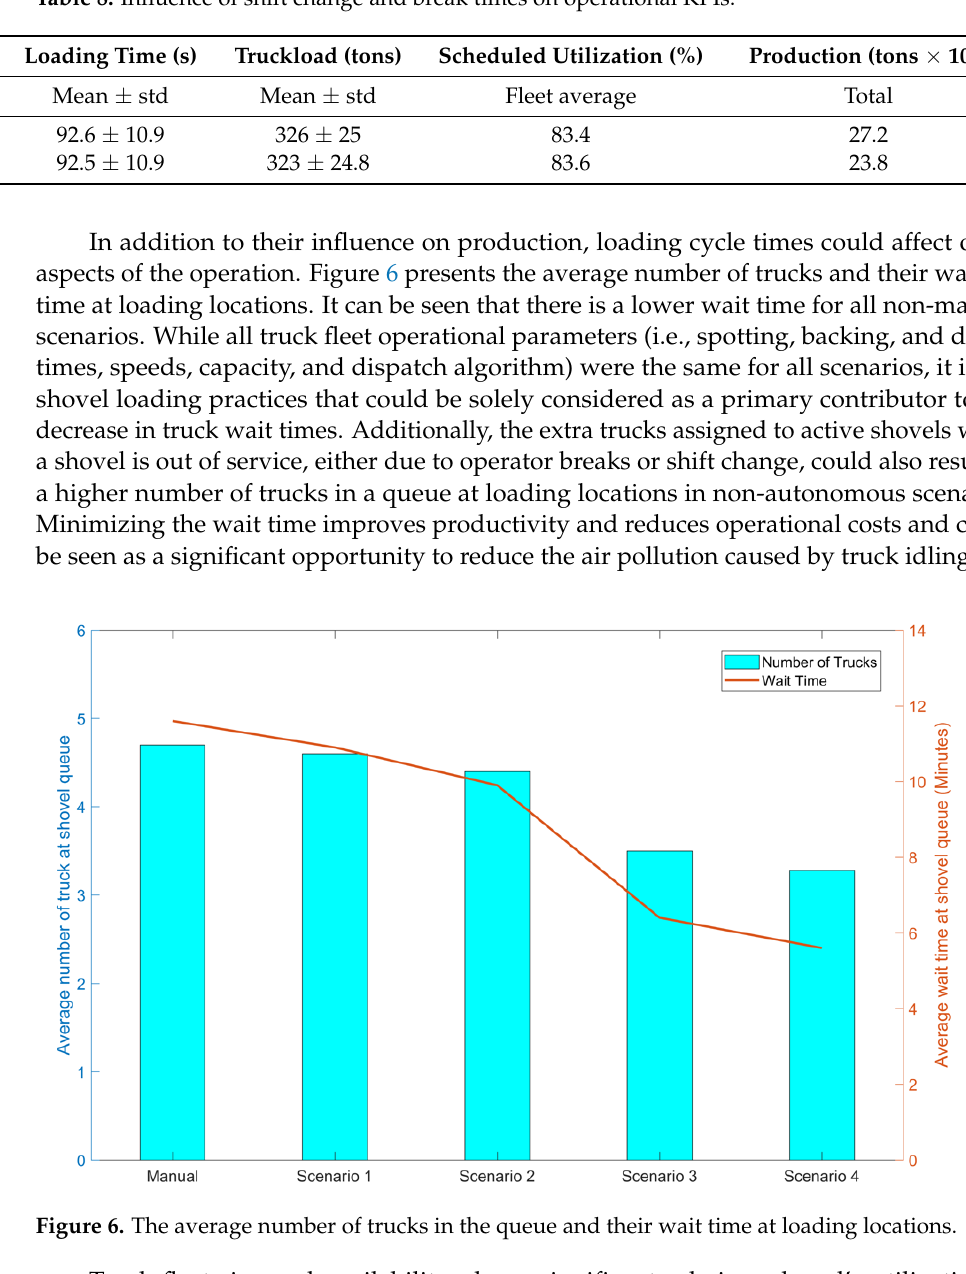
Table 8. Influence of shift change and break times on operational KPIs.